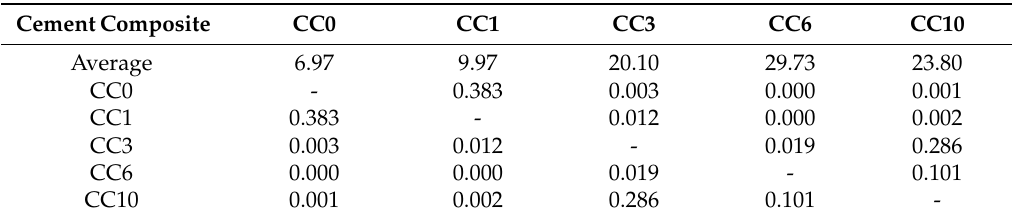
Table 8. Confidence levels for the Duncan test. p -value for the Duncan test for the root growth inhibition test of Sinapis alba.